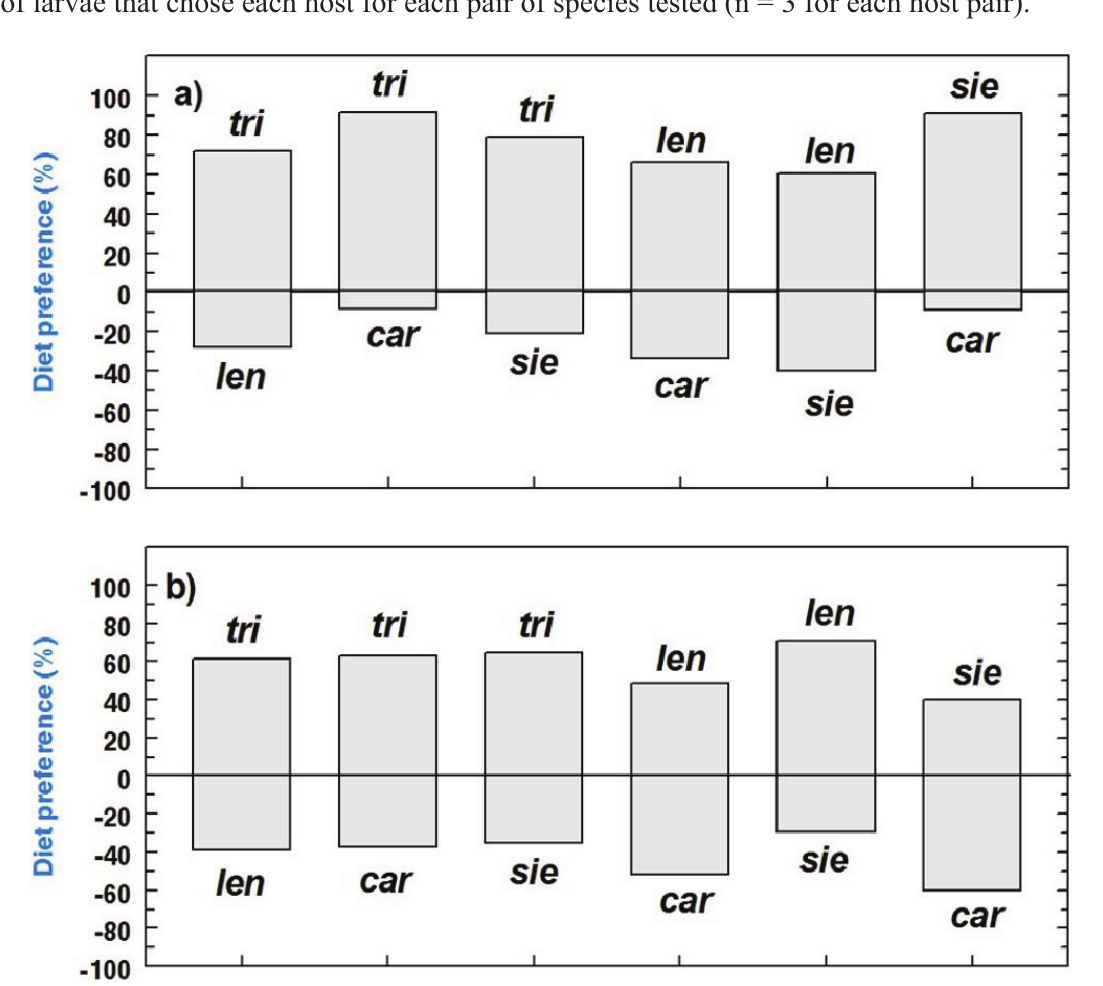
Viburnum species: V. trilobum ( tri ), V. lentago ( len ), V. carlesii ( car ), and V. sieboldii ( sie ) for larvae weighing ( a ) less than 6 mg, and ( b ) more than 6 mg. Y-axis indicates the percentage of larvae that chose each host for each pair of species tested (n = 3 for each host